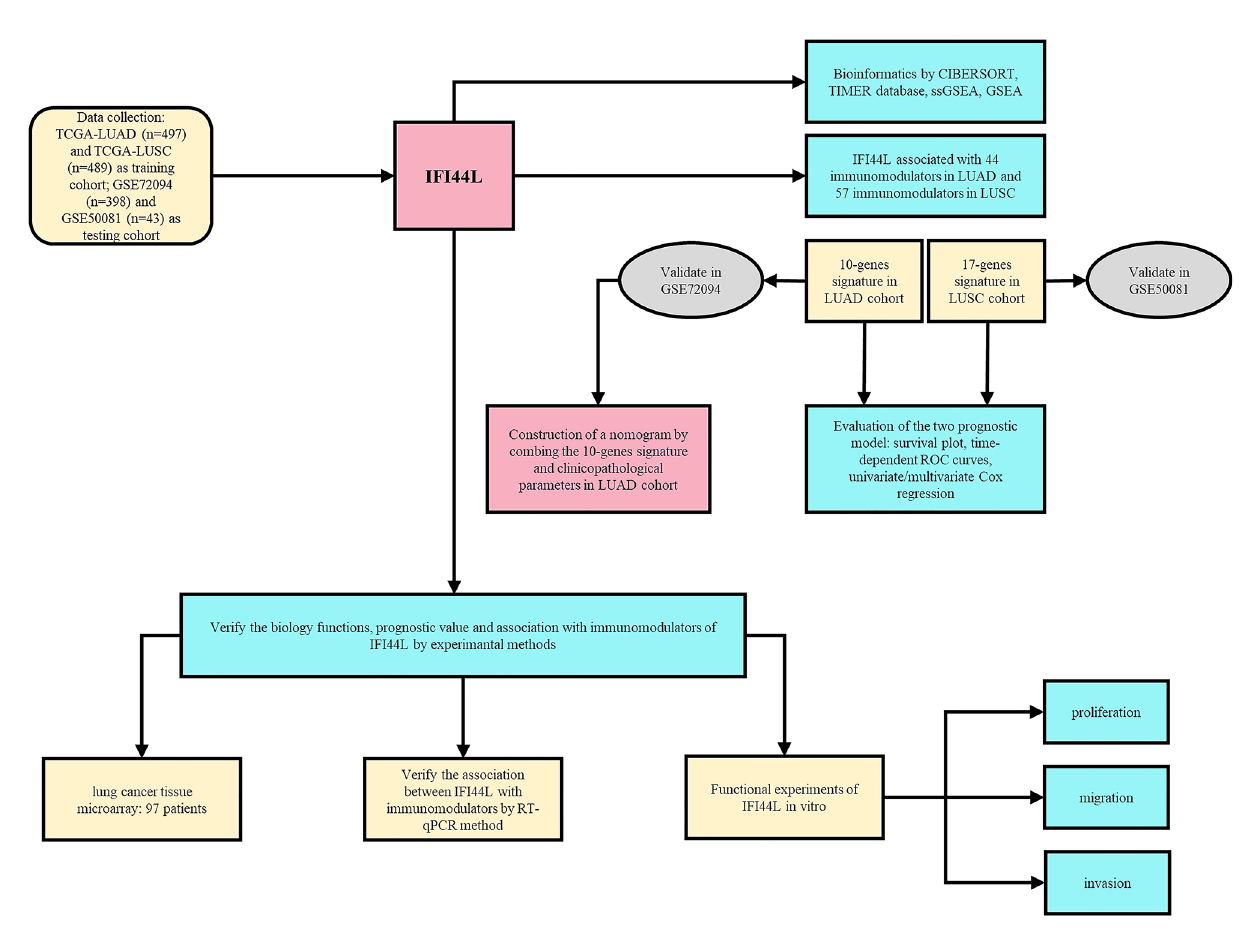
FIGURE 1 | Flowchart of this